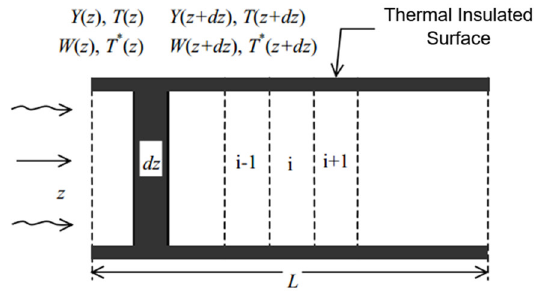
Figure 4. Computational grid.